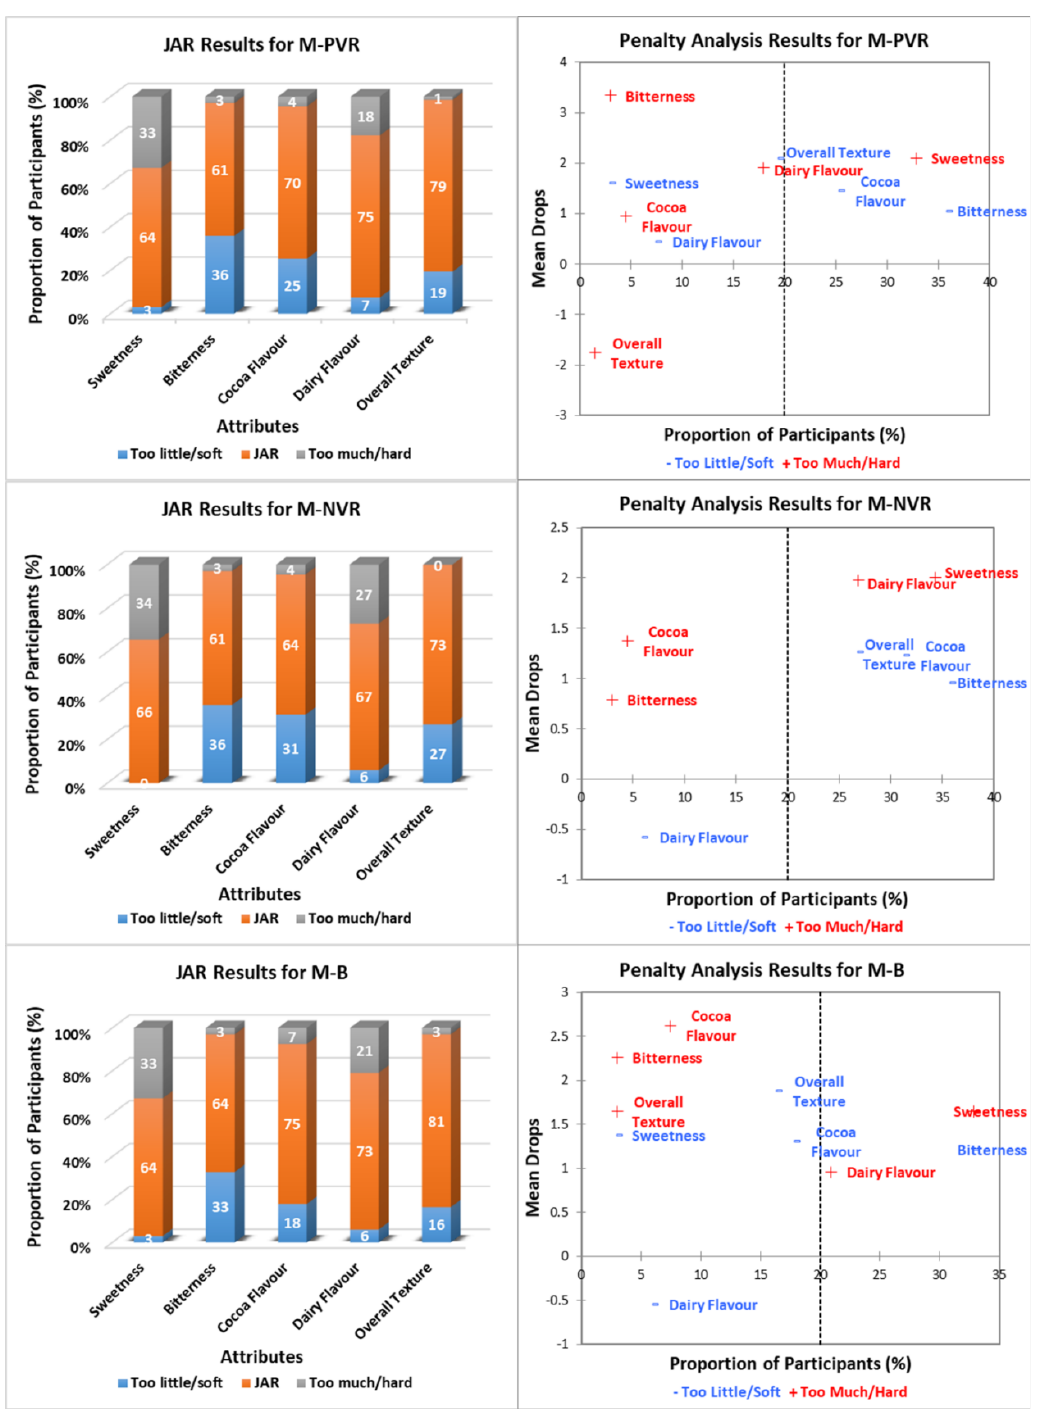
Figure 3. Just-About-Right (JAR) frequencies and penalty analysis results 1 regarding milk chocolate attributes under different environments 2 . 1 Penalty analysis was associated with the overall liking scores (9-point hedonic scale). 2 M-PVR: milk chocolate positive VR; M-NVR: milk chocolate negative VR; M-B: milk chocolate sensory booth.